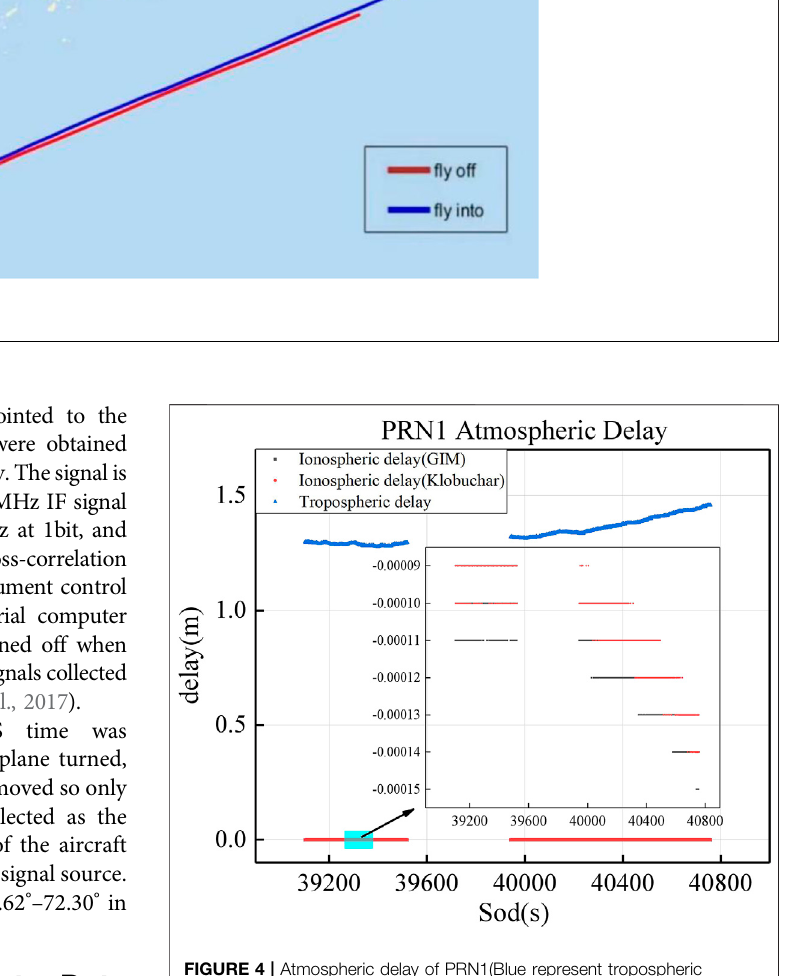
FIGURE 4 | Atmospheric delay of PRN1(Blue represent tropospheric delay,redrepresentstheresultsoftheKlobucharmodel,andblackrepresent. the results of GIM